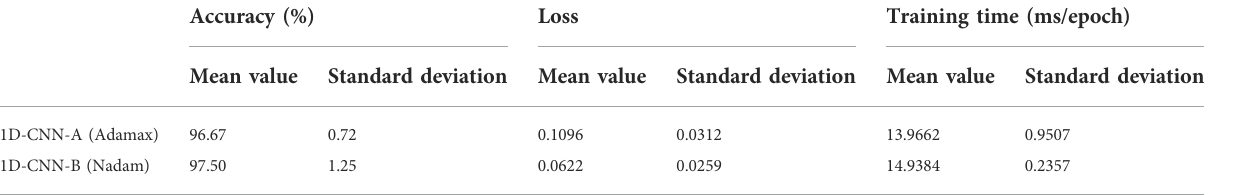
TABLE 2 Comparison of performance under the two types of shallow 1D-CNN optimal